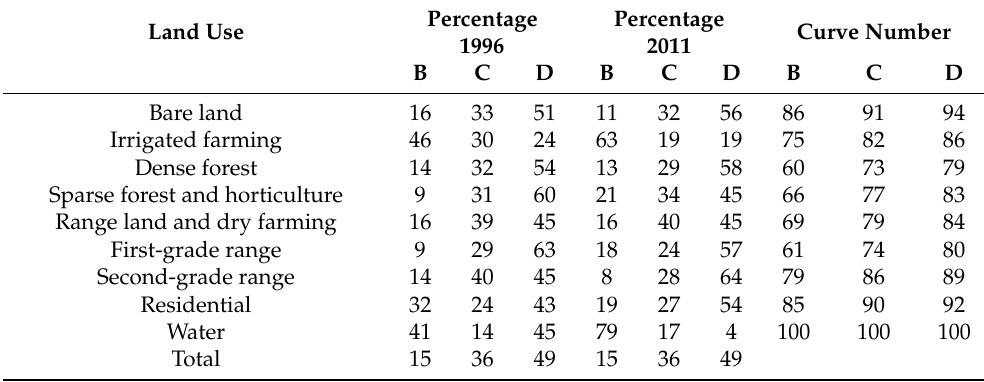
Table 6. Proportions and curve numbers of hydrological groups B, C, and D (group A does not exist in the study area). See Table 2 for the explanation of hydrological